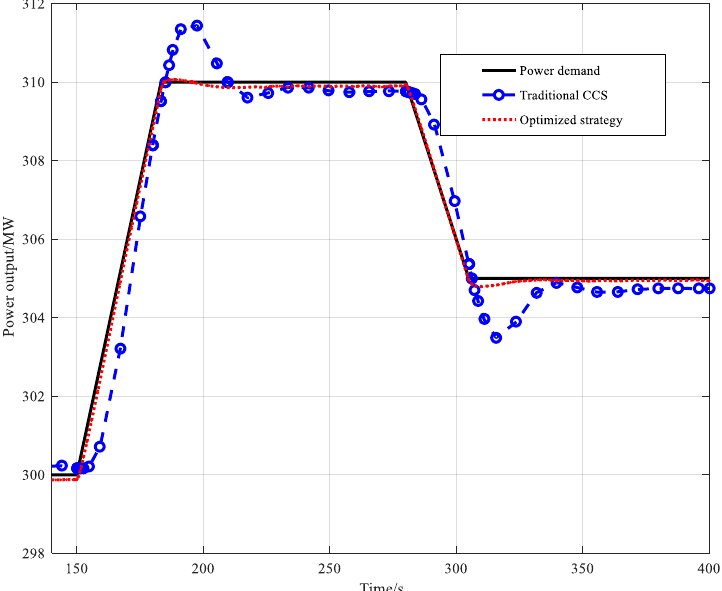
Figure 10. Response curves of power output with power ramp input by two different strategies.